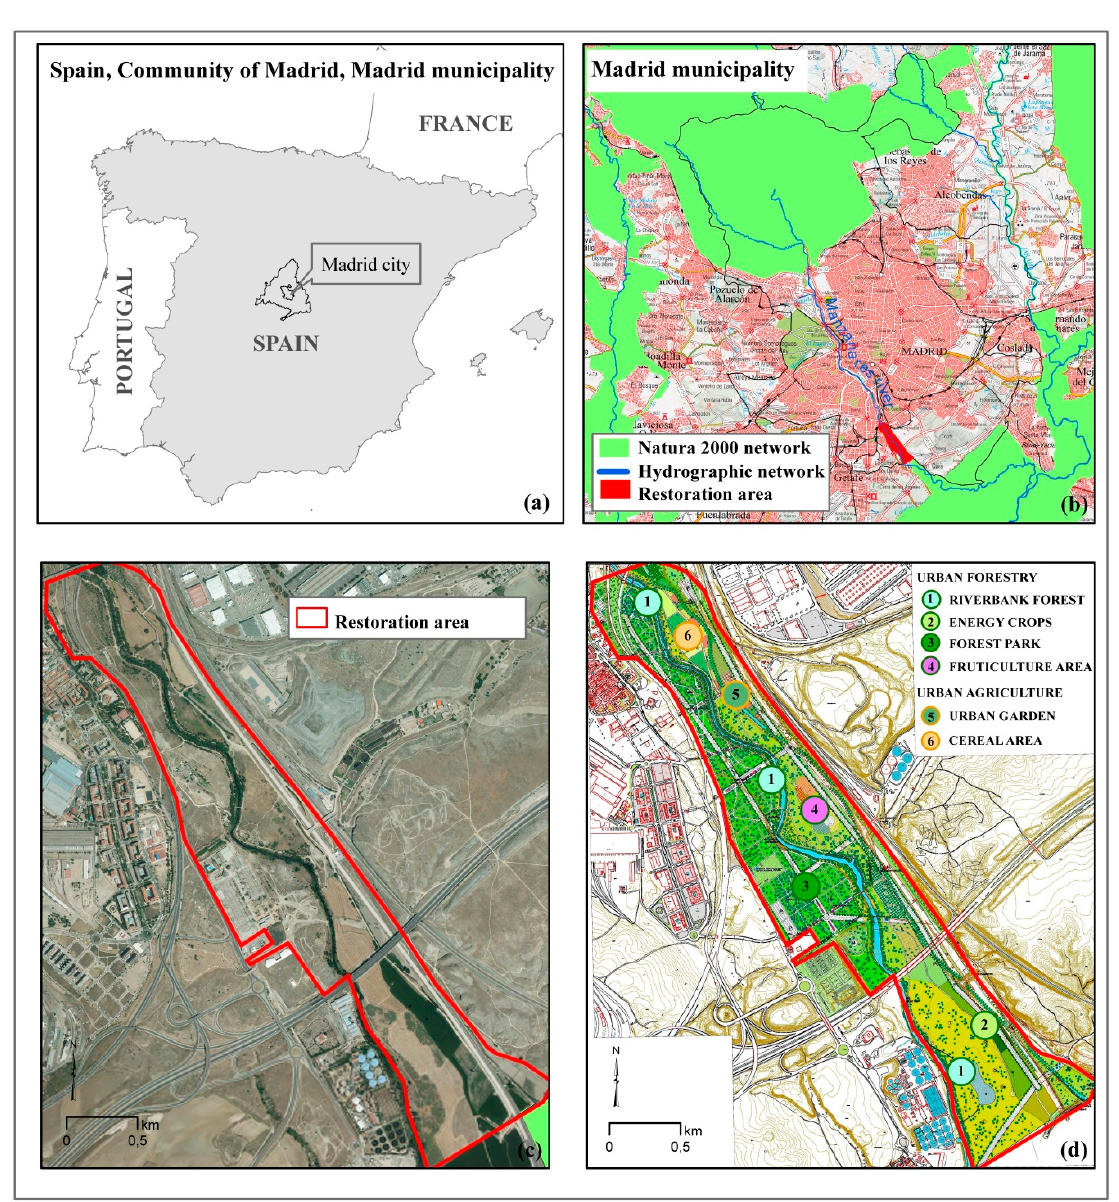
Figure 1. Visual information about the project: ( a ) Location of the project in the Community of Madrid and Spain; ( b ) Framework in which the project is inscribed in the municipality of Madrid, where the Manzanares River functions as a connector for protected natural areas (Natura 2000 network); ( c ) pre-operational situation; ( d ) postoperacional situation. Source: ( a – c ) Municipal and regional limits, National Cartographic Base at scale 1:200,000, Orthophoto mosaics of the National Plan for Aerial Orthophotography. National Geographic Institute, Government of Spain ( d ) Own elaboration from the construction project.